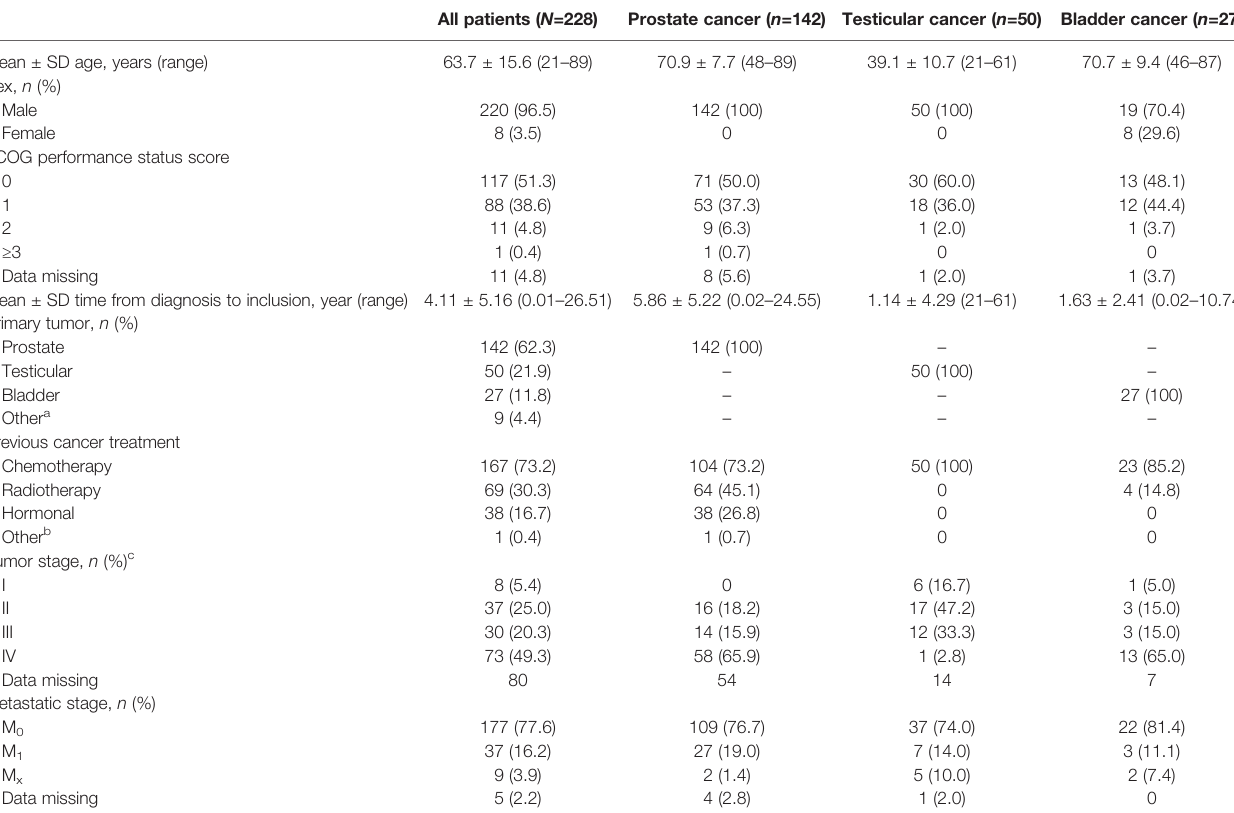
TABLE 1 | Demographics and clinical characteristics.